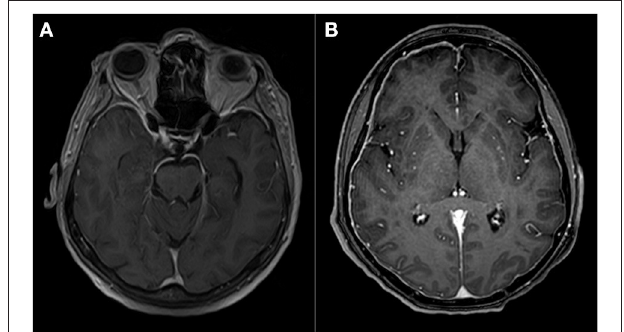
FIGURE 3 | T1 contrast-enhanced images (A,B) show pachymeningeal enhancement in two different patients, indicative of meningitis. In case (A) , it was an isolated finding, while in case (B) , coexisting white matter lesions suggestive of acute demyelination were present.